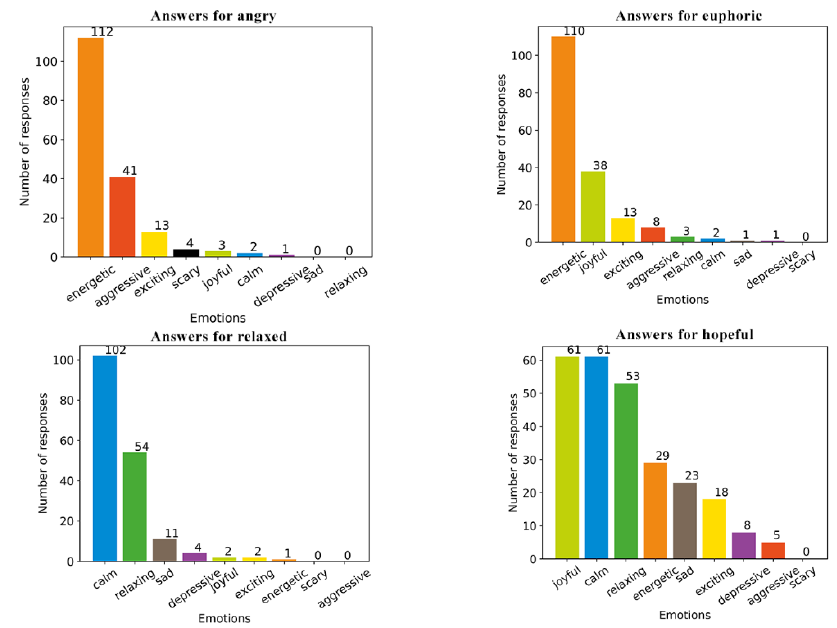
Figure 7. Histograms of the responses for emotions matching with Epidemic Sound.